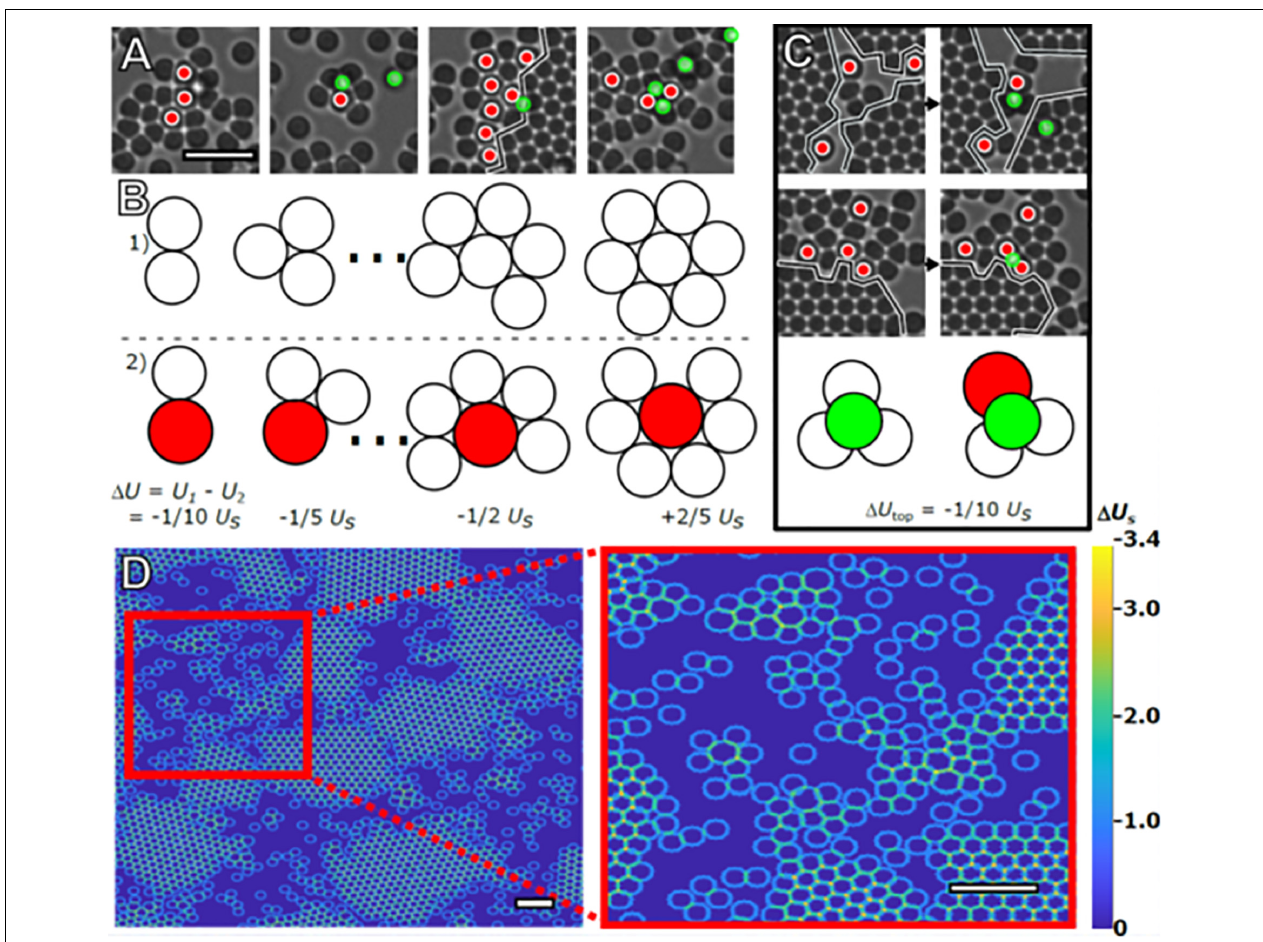
FIGURE 5 | Stabilization of amorphous clusters. Four representative images of the intermixing of large and small particles taken from the same time frame (A) . Red circles mark large particles. The black line marks the boundary of crystal islands (scale bar = 4 µ m). Using U s as the bond energy between two small particles in contact due to depletion, the effect of the increased bond strength on total cluster bond energy is illustrated in (B) . 2D clusters of small particles (Row 1) have a higher total bond energy, U , compared to clusters containing a large particle (Row 2), and until close-packed clusters of seven particles are formed. Particles are drawn to scale. Images of promotion and/or capture events occurring between subsequent frames are displayed in (C) . The illustration demonstrates the energetic preference, (cid:49) U top , for adatoms (green) occupying interstitials formed with large particles vs. those formed with only small particles. These configurations are commonly observed in the experiment, with examples also visible in (A) . (D) Heat map demonstrating the different energetic configurations presented to a hypothetical small particle that takes up residence on the second layer due to the presence of particles present on the substrate. Although there are relatively strong bonding locations located at the interstitial sites (orange) and troughs (teal), there are stronger bonding locations in the amorphous areas near large particles (scale bar = 4 µ m, inset scale bar = 4 µ